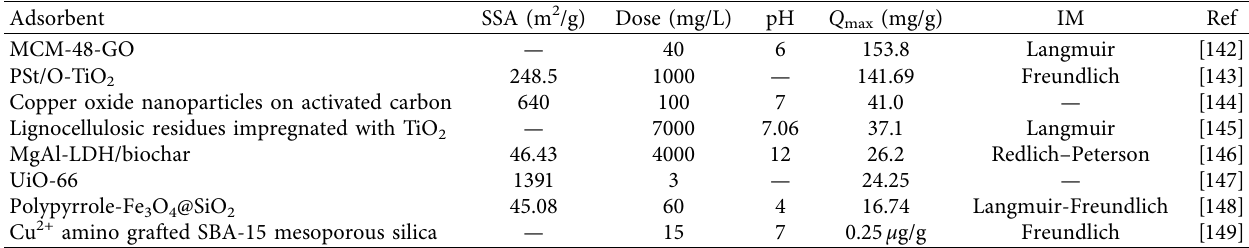
Table 11: Summary of characteristics of the composite adsorbent organic-organic types and conditions of the adsorption process. Adsorbent Chitosan-reduced graphene oxide Graphene-chitosan Table 12: Summary of characteristics of composite adsorbent organic-inorganic types and conditions of the adsorption process. Adsorbent